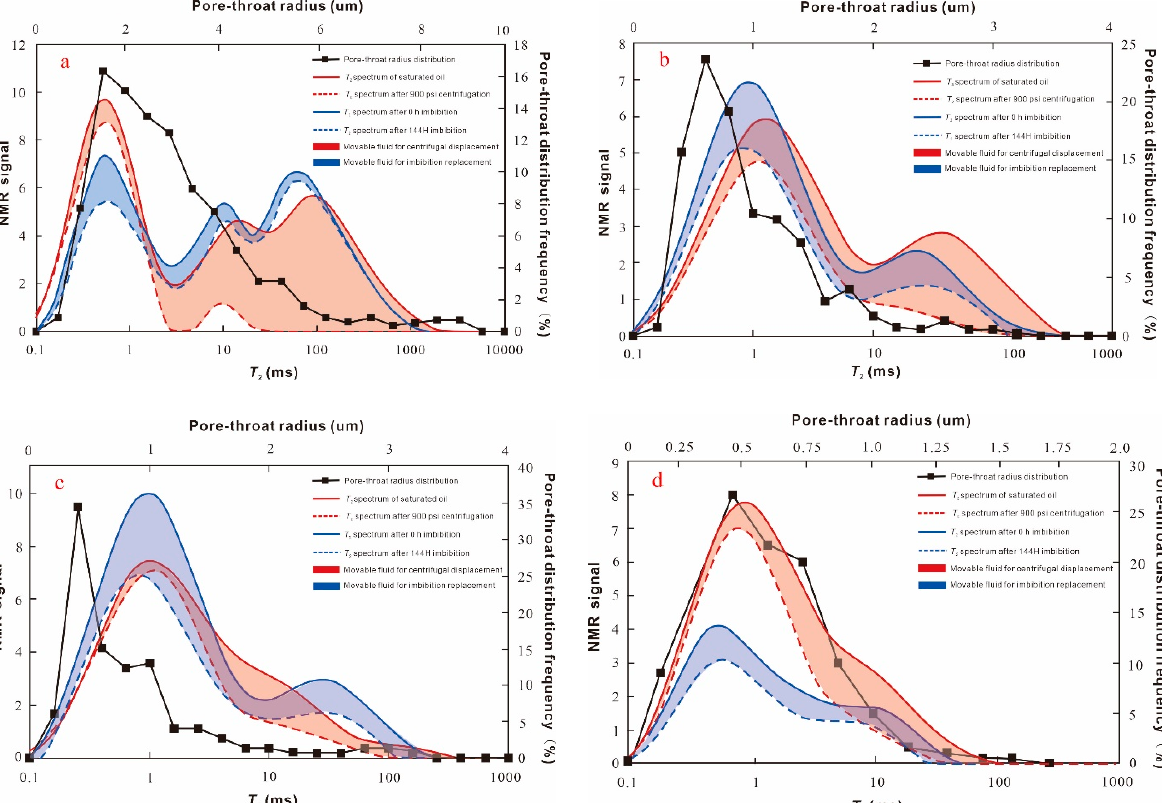
Figure 16. Migration rule of crude oil in pore throats of different types of reservoirs; ( a ) Type I reservoir; ( b ) Type II reservoir; ( c ) Type III reservoir; ( d ) Type IV reservoir. Table 5. Oil recovery of different types of reservoirs.